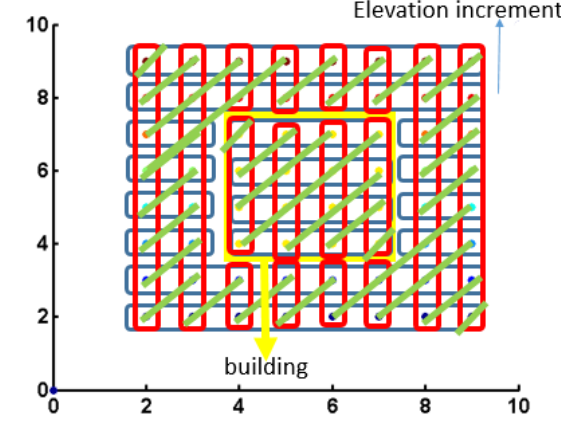
Figure 2. Segmentation the point cloud, the building and bare earth are segmented using three different profile